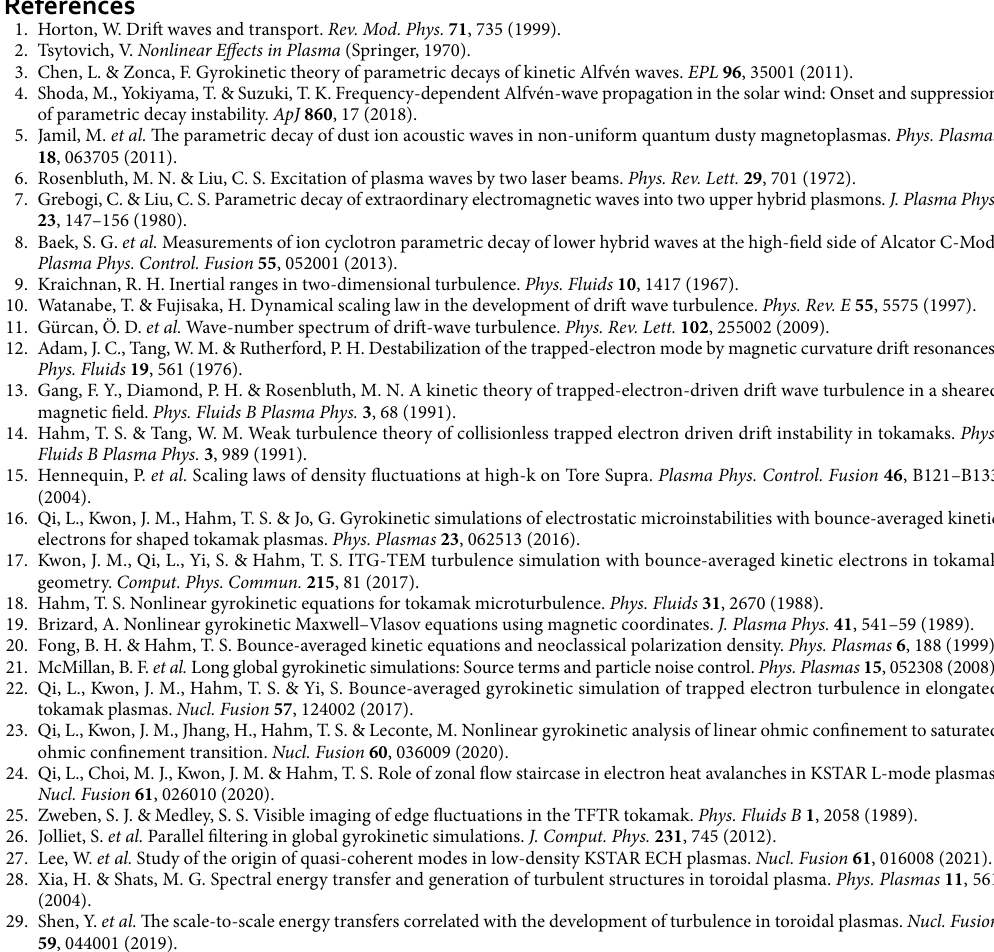
Figure 6. Overall picture of the energy transfer process. Plot of (black), 33 R / V Ti (blue) and 90 R / V Ti (red) shows the energy transfer in trapped electron